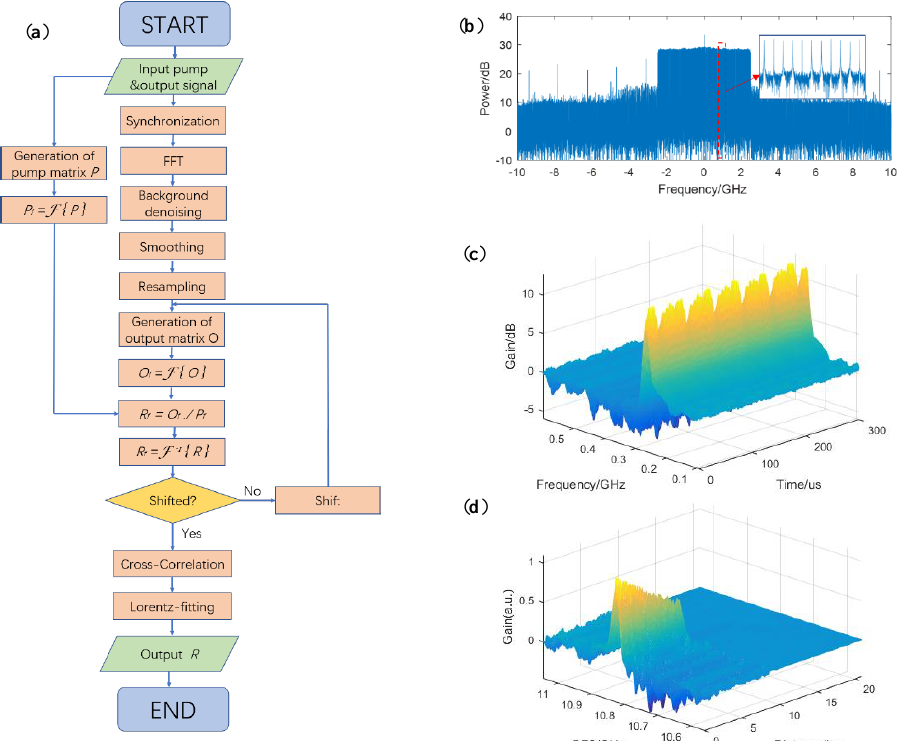
Figure Figure 5. ( a ) Flowchart of digital signal processing; ( b ) DOFC signal in frequency domain; ( c ) experimental periodic received output signal from the sensing system; ( d ) calculated impulse response matrix.